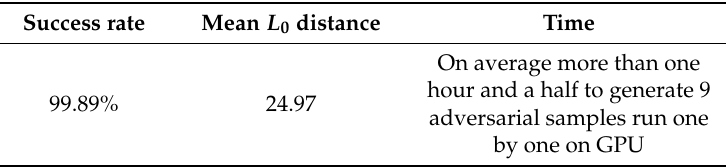
Table 5. Results for L 0 CW on